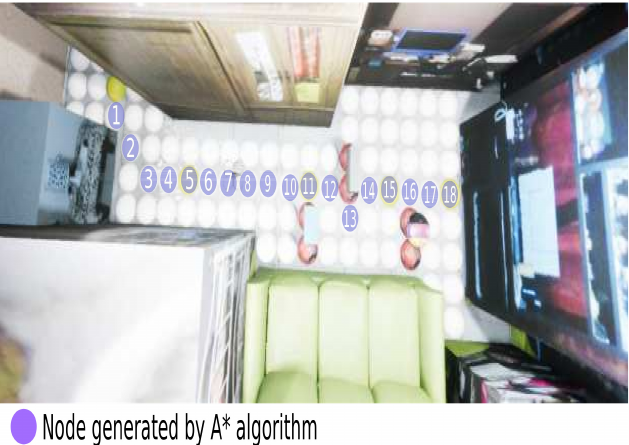
Figure 6. Visual representation of the best path employing the A ∗ algorithm. The navigation mesh technique offers a reduction in the nodes required to find the best path. Figure 7 describes a manual representation of the scenario’s simplification using meshes where the nodes are grouped into an area to calculate the region’s centroid. using this technique. Another advantage of applying navigation meshes being able to move faster without jumping 20 cm each time, as shown in Figure